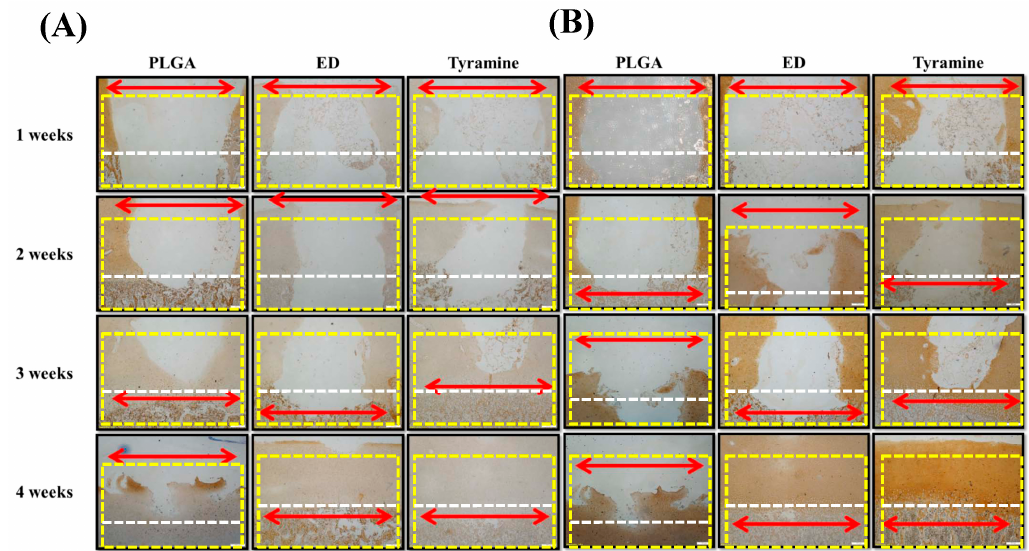
Figure 6. Histological analysis of co-cultured bilayered PLGA scaffold and porcine osteochondral plug by Alcian blue staining. Magnification: 40×; scale bar: 200 μ m. Red double-headed arrows ( ←→) indicate the defect area after tissue regeneration. Yellow dotted boxes indicate the defect area before tissue regeneration.